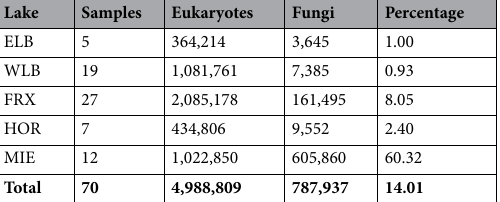
Table 1. Number of samples and proportion of fungal sequence reads relative to the total number of eukaryotic reads obtained from each lake